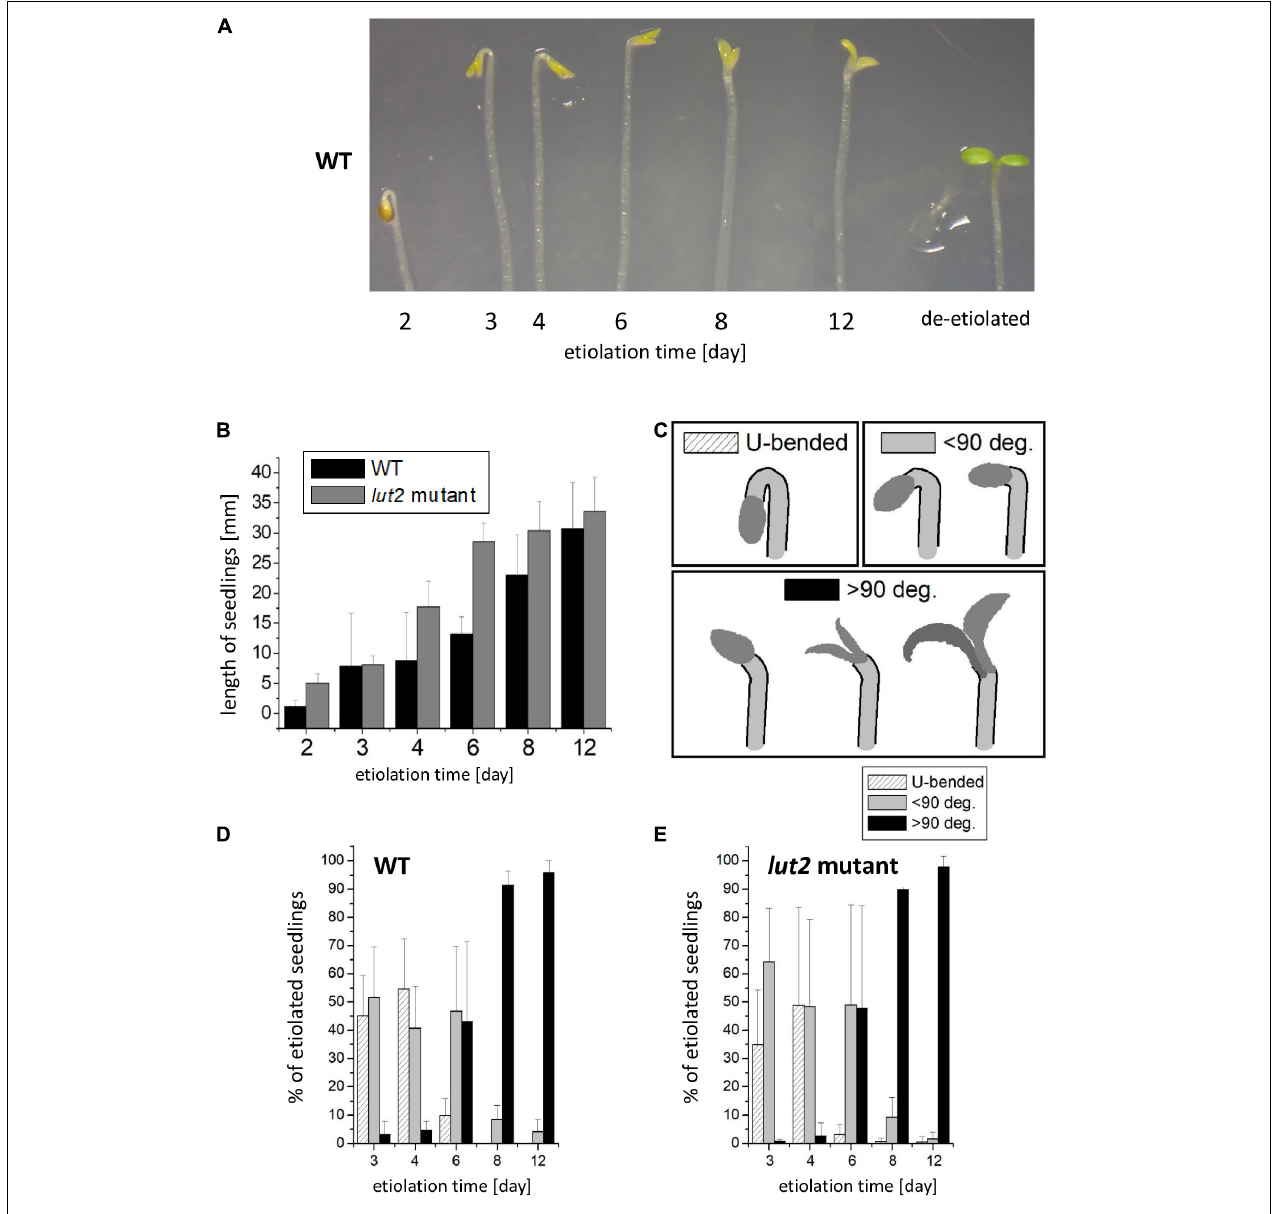
FIGURE 1 | Morphology of dark-grown Arabidopsis thaliana seedlings of wild type (WT) and lut2 mutant. (A) A representative picture of seedlings showing the cotyledon opening and the curvature of an apical hook during the etiolation; for a comparison, 6-day-old etiolated seedling then de-etiolated for 24 h is shown. (B) The length of seedlings. Bar heights represent arithmetic mean, while error bars represent SD; n = 3 repetitions (100–300 seedlings per replicate). (C) Representation of arbitrary categories for seedling classification regarding the curvature of an apical hook. (D,E) The percentage share of the particular categories in the population of seedlings at different ages for WT and lut2 mutant. Bar heights represent arithmetic mean, while error bars represent SD; n = 5 repetitions (100–300 seedlings per replicate). Statistically significant differences for data shown in panels (C–E) are shown in Supplementary Data 5